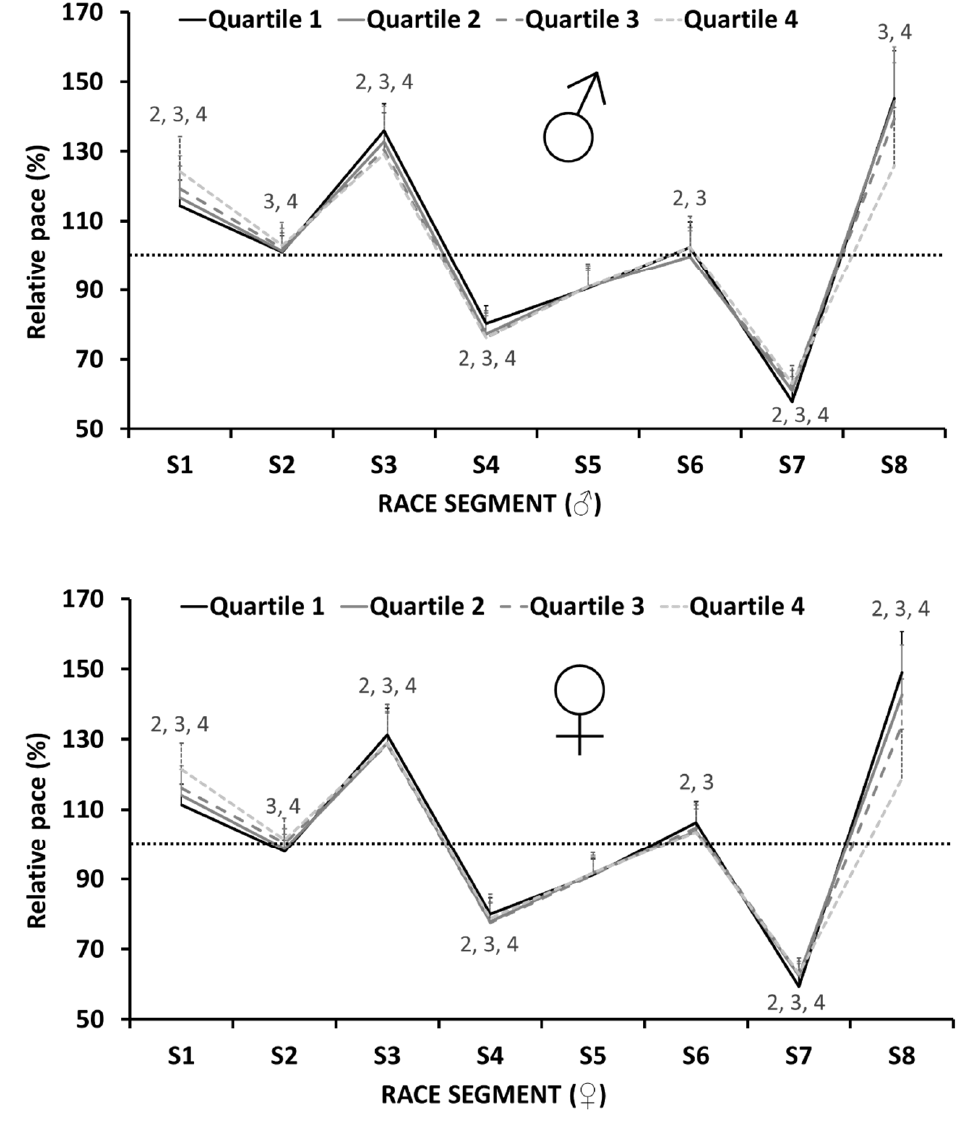
Figure 2. Relative pace (%) in the different race segments (S1–S8) of males ( ♂ , n = 4380) and females ( ♀ , n = 1276) who participated in the 2017, 2018, 2019, and 2021 editions of the OCC ® , according to their performance levels. The numbers represent significant differences between Q1 and quartiles Q2, Q3, and Q4 (i.e., Q1 to Q2, Q1 to Q3, and Q1 to Q4).